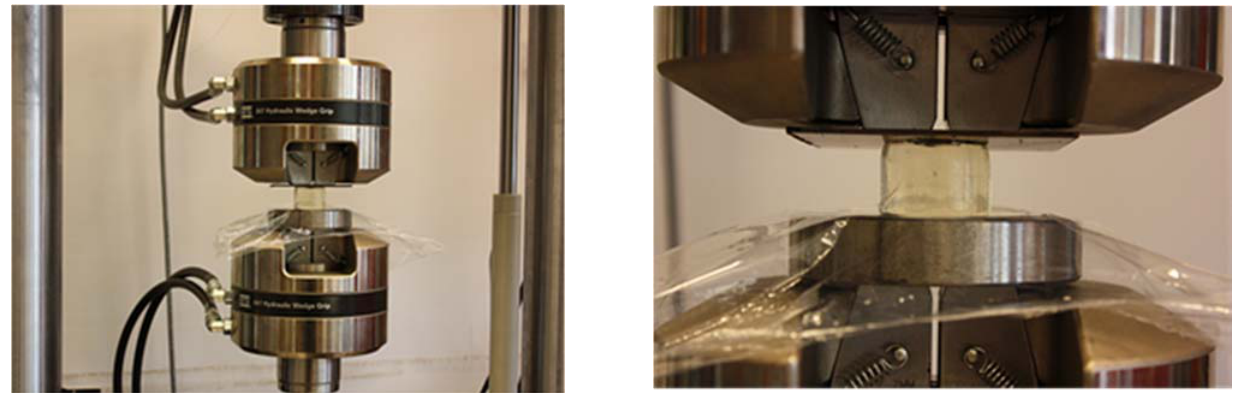
Figure 12. MTS Bionix mechanical testing system equipped with a 1-kN load cell.